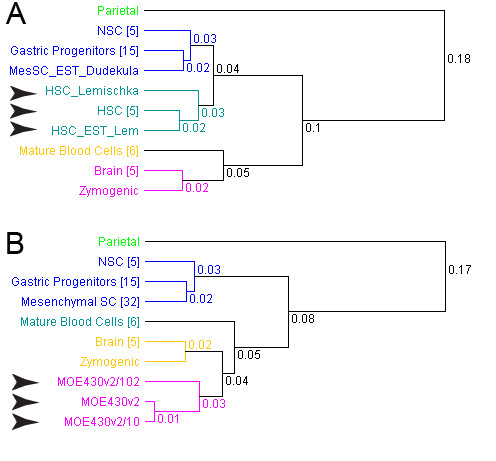
GOurmet can cluster expression profiles from varying platforms, from different labs, and of different lengths. A) Three different hematopoietic stem cell (HSC) expression profiles (one generated from a subtracted library [16], two from different GeneChips in different labs [5,6]) all cluster most closely with each other (marked by arrowheads) than with any of the other progenitor or differentiated cell profiles. B) A parent gene list composed of every annotated gene on the Moe430V2.0 GeneChip was reduced in length 10-fold by random exclusion of 9 in 10 genes and 100-fold by exclusion of 99 in 100 genes. The reduced length versions of the original list still cluster with the parent (marked by arrowheads). [32]